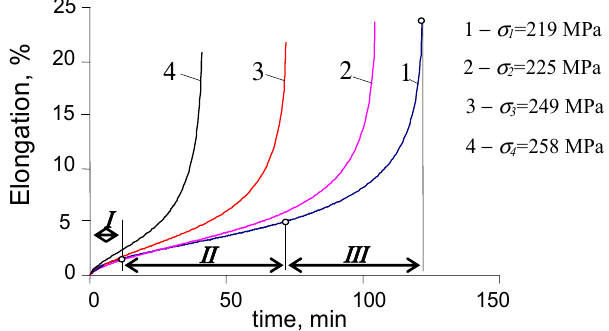
Figure 7. Sample elongation in creep test.